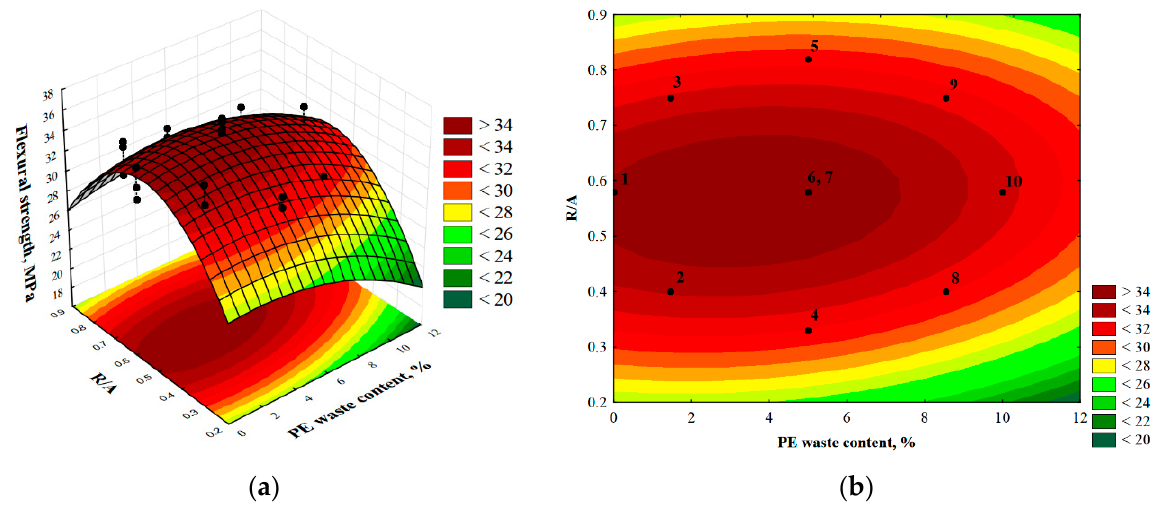
Figure 12. Three-dimensional ( a ) and contour ( b ) plot of the response surface for flexural strength.